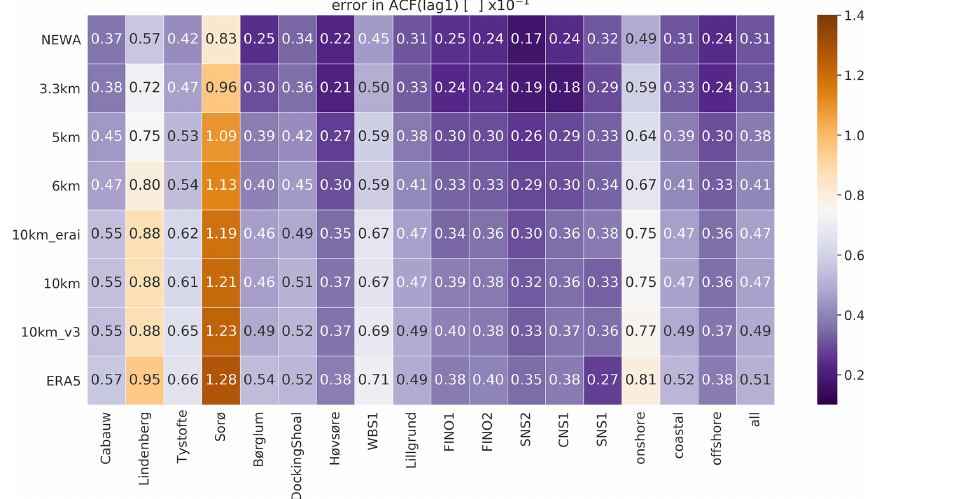
Figure 4. Error in autocorrelation function (ACF) at lag = 1h of simulated time series to measurements for the various experiments in Table 1 and reanalyses. The darkest purple colours are the best results; the darkest brown is the worst. The rows are sorted by the column median all, with the most accurate results on the top and the least accurate results on the bottom of the